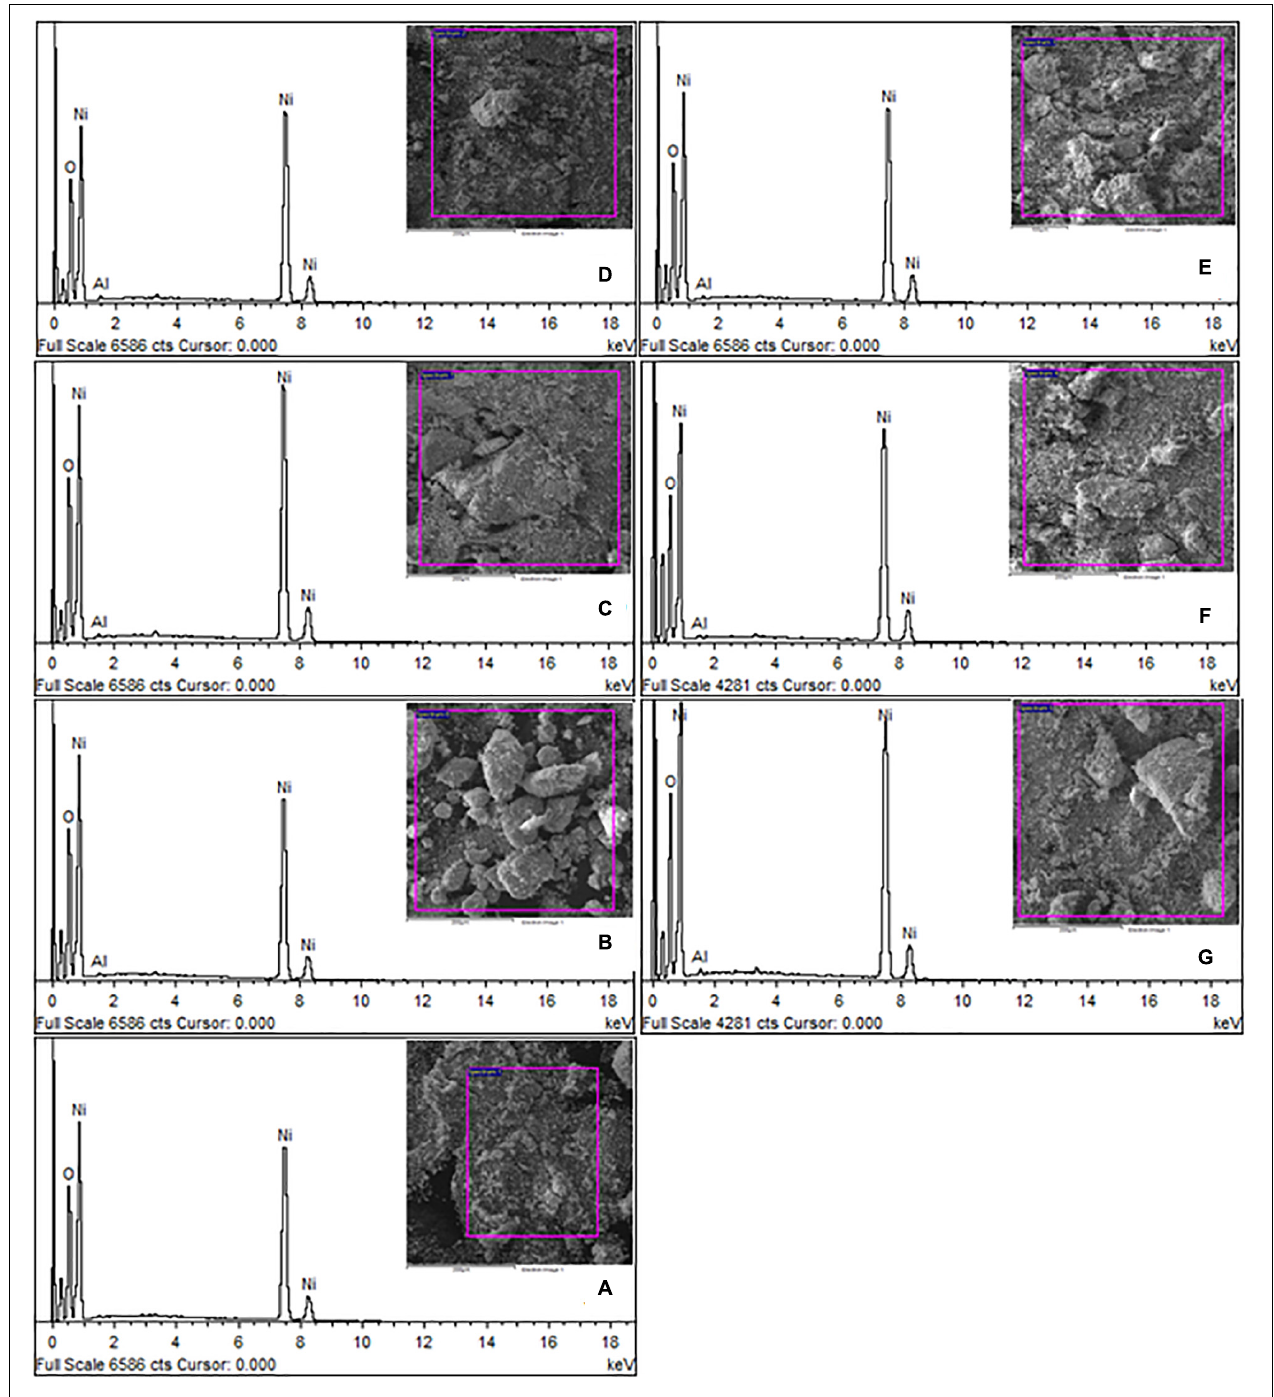
FIGURE 3 | (A–G) EDX spectra of Ni 1 − x Al x O; x = 0, 5, 10, 15, 20, 25, and 30 wt.% nanoparticles,